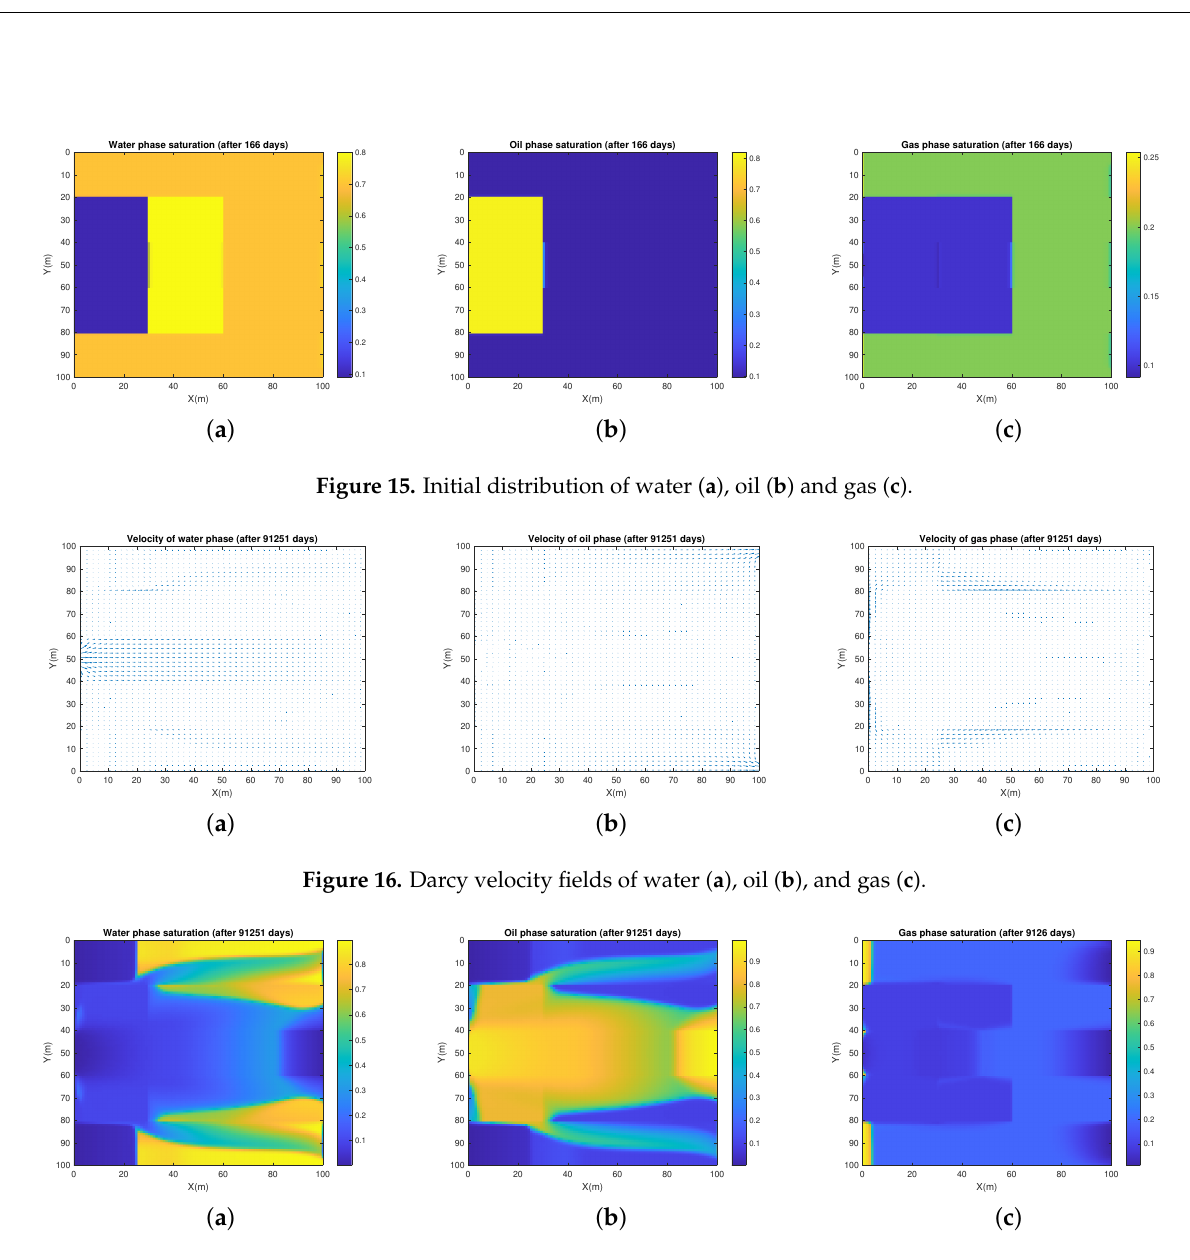
Figure 17. Saturation distribution of water ( a ), oil ( b ) and gas ( c ). Finally, we calculated the residual (mass conservation error) of saturation equation ∞ for each phase at every time step in the simulation by l norm given by formula (51). For the improved IMPES scheme, the calculated mass conservation errors of three phases at all simulation time steps are in the magnitude of 10 − 16 , which is considered to be zero without the round-off error. We also ran this example with the same conditions using a conventional IMPES scheme and calculated the residual of mass conservation equation of each phase. The calculated errors of two referred phases (water and gas) at all simulation time steps are in the magnitude of 10 − 16 . However, we also calculated the global error for each phase at all simulation time steps and found that the global error of non-referred phase is accumulating from in magnitude of 10 − 10 to 10 − 4 .